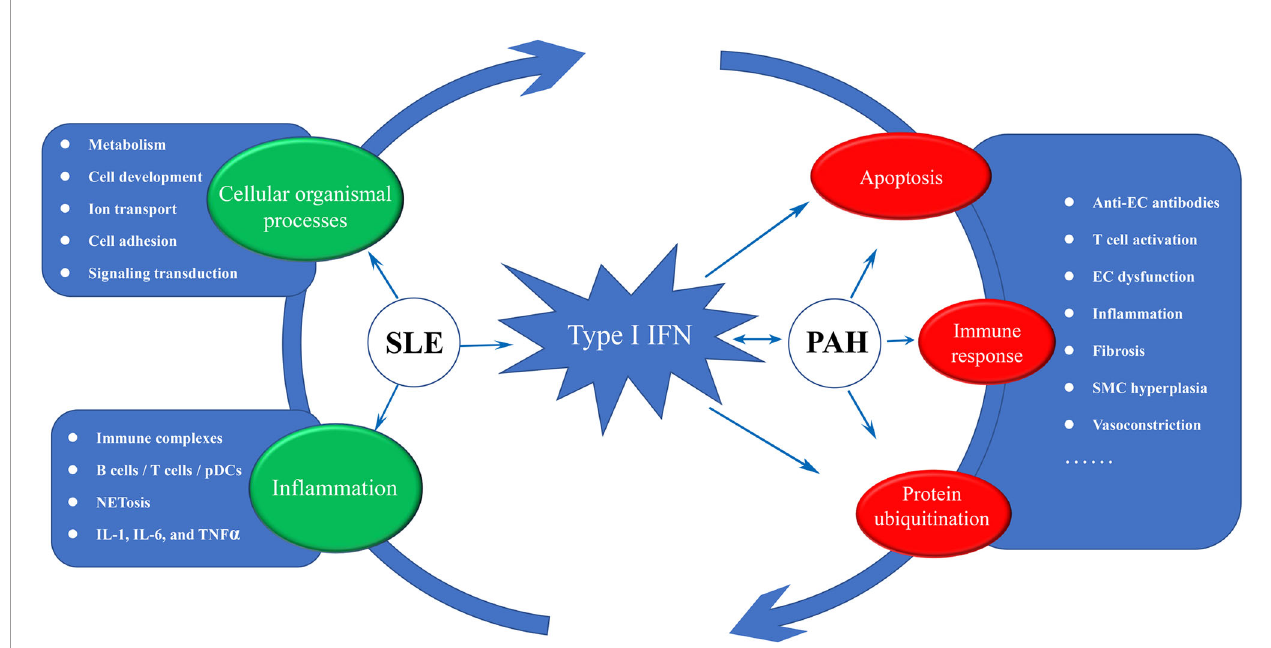
FIGURE 9 | The disease road model. Type I IFN plays a central role in the disease road model. The impaired cellular organismal processes, persistent in fl ammation and high activated IFN response were signi fi cant characteristic in SLE, and some key words associated with three biological processes were display. In PAH, high IFN response forms a complex reciprocal network with the apoptosis, T cell activation and protein ubiquitination, resulting in in fl ammation and fi brosis. IFN, interferon; EC, endothelial cell; SMC, smooth muscle cell; SLE, systemic lupus erythematosus; PAH, pulmonary arterial